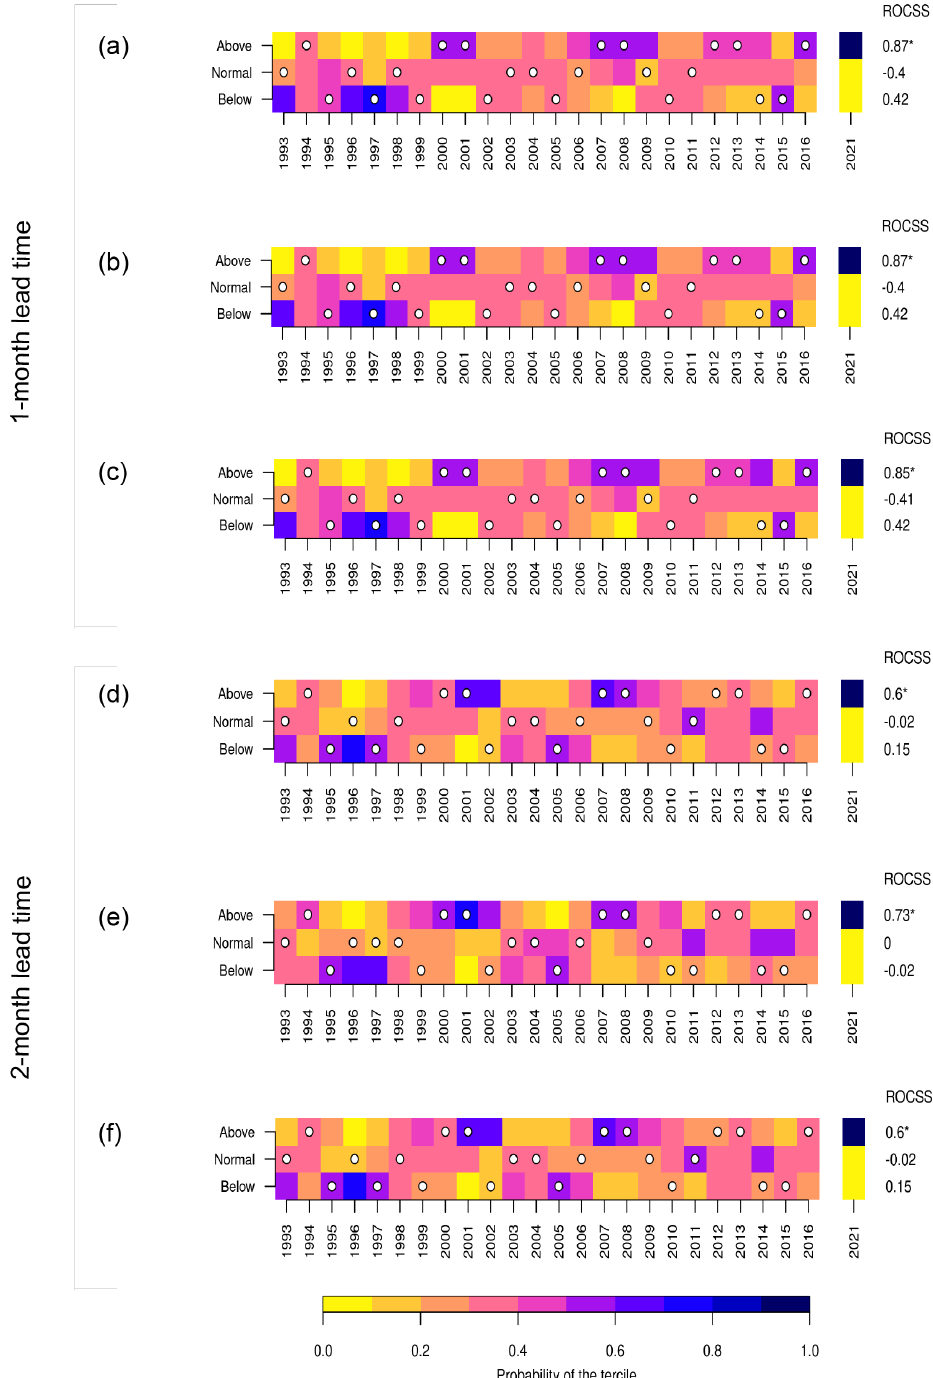
Figure 6. Same as Fig. 3 but for ISI